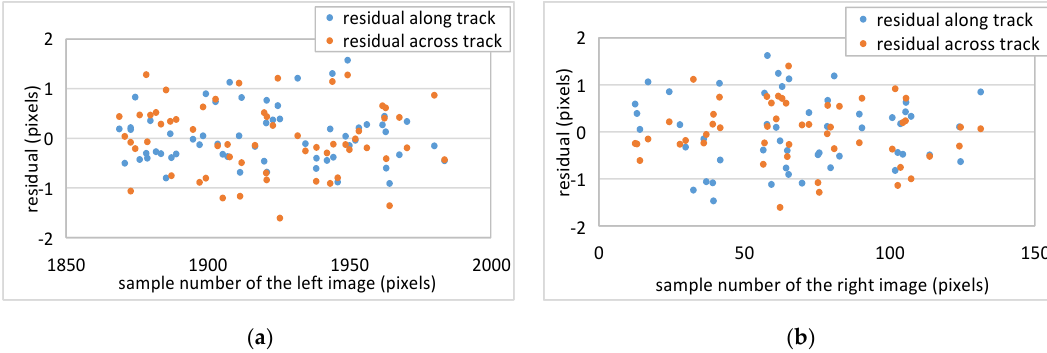
Figure 11. Relative orientation residual(unstable platform): ( a ) residual of left-middle images; ( b ) residual of right-middle images. Table 11. Stitching error of EA-unstable-1.